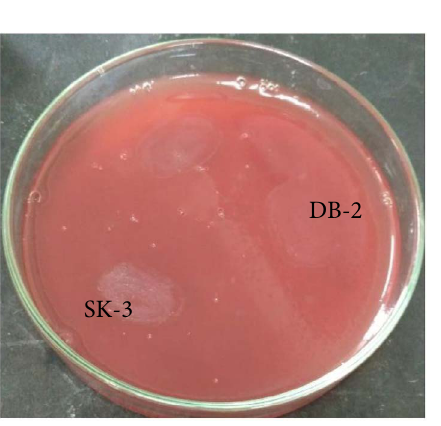
Fig. 5. Antibiotic susceptibility